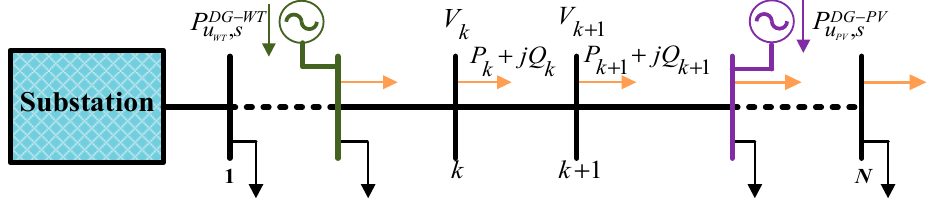
Figure 1. Distribution network model.